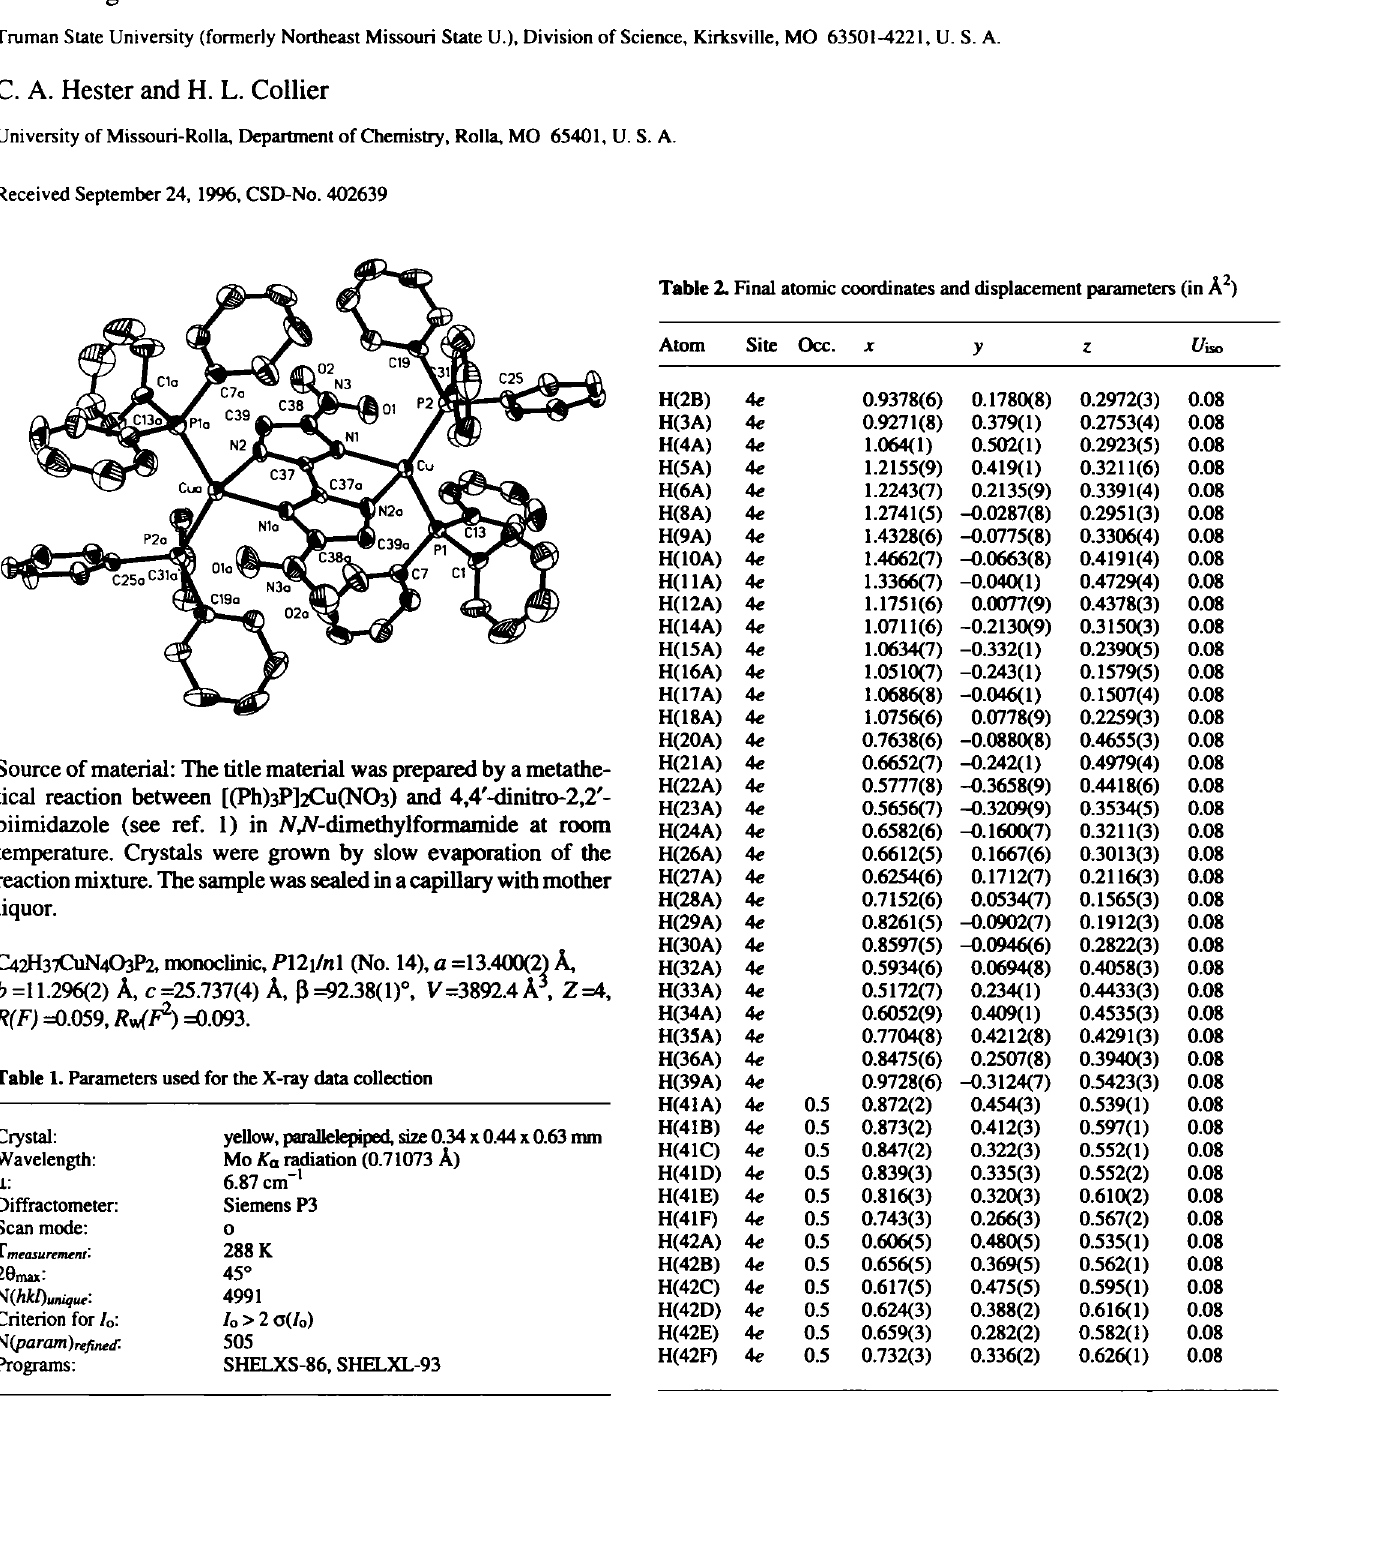
Table 1. Parameters used for the X-ray data collection